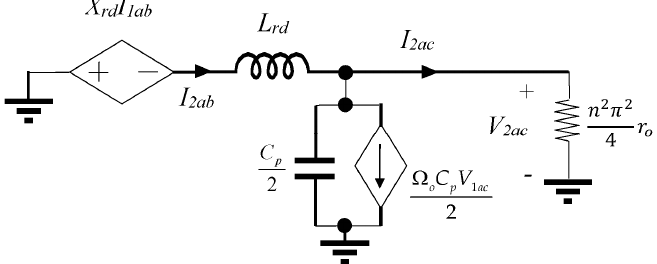
Figure 8. Imaginary part of the large-signal reduced-order envelope model of the inverter stage.